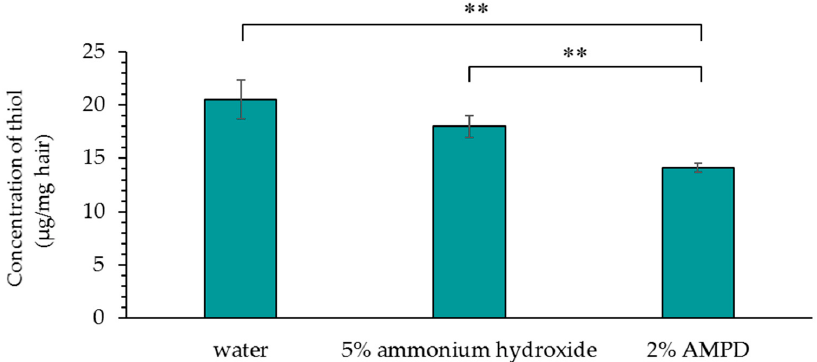
Figure 6. The concentration of thiol groups (-SH) produced by cleavage of disulfide bonds in human hair after using 5% ammonium hydroxide or 2% AMPD aqueous solution as an alkaline agent. The results are expressed as the mean ± standard deviation of three experiments. ** p < 0.01 vs. ammonium